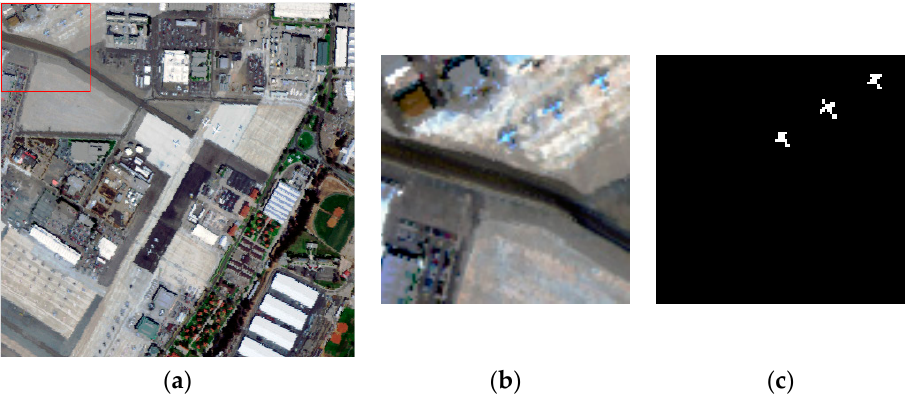
Figure 6. AVIRIS_SanDiego dataset: ( a ) false-color image of the whole scene; ( b ) false-color image of the detection area; ( c ) the ground-truth map.